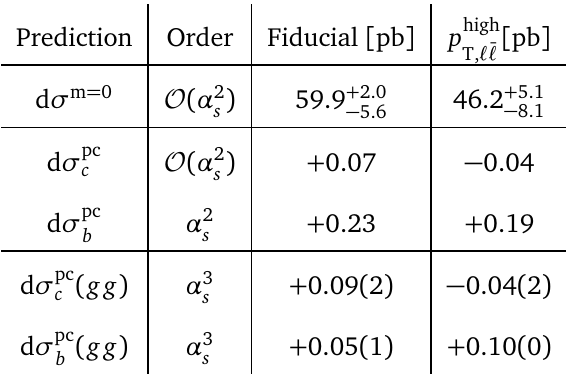
Table 2: Predictions for the DY cross-section within the LHCb fiducial region with m (cid:96) ¯ (cid:96) ∈ [ 12.5,13.5 ] GeV. The contributions from the massless calculation and the massive power-corrections are shown for the central scale. The scale uncertainties ) prediction are indicated, and the uncertainties in parenthesis of the massless O ( α 2 s correspond to the fit uncertainties of the α 3 coefficients. s